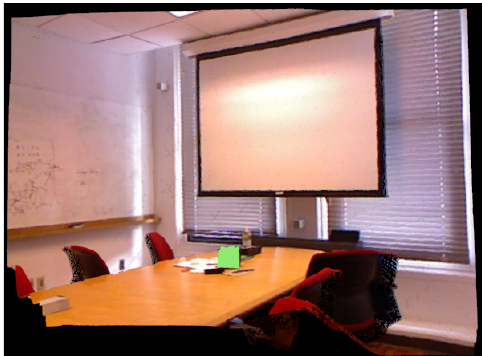
Figure 16. A cup on a